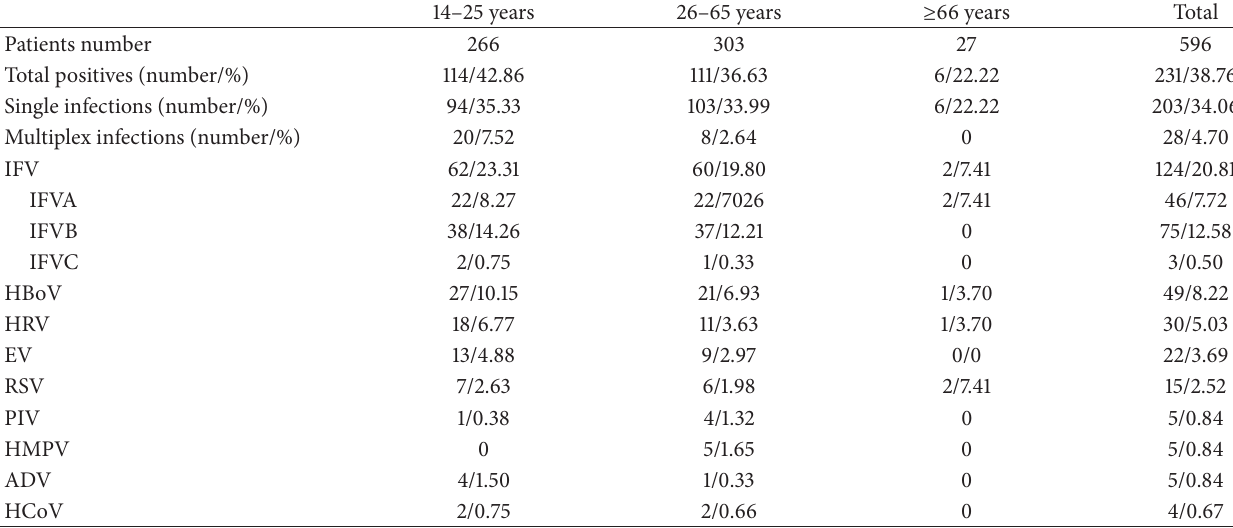
Table 2: Spectrum of respiratory virus infections according to age groups.